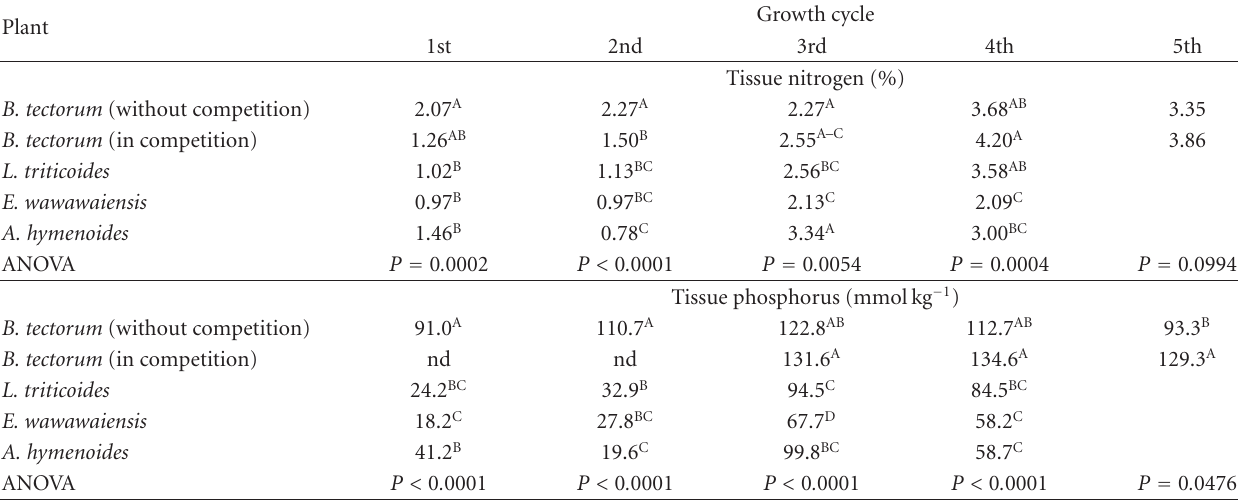
Table 5: Mean above-ground tissue nitrogen and phosphorus concentrations by plant species and growth cycle. Plant